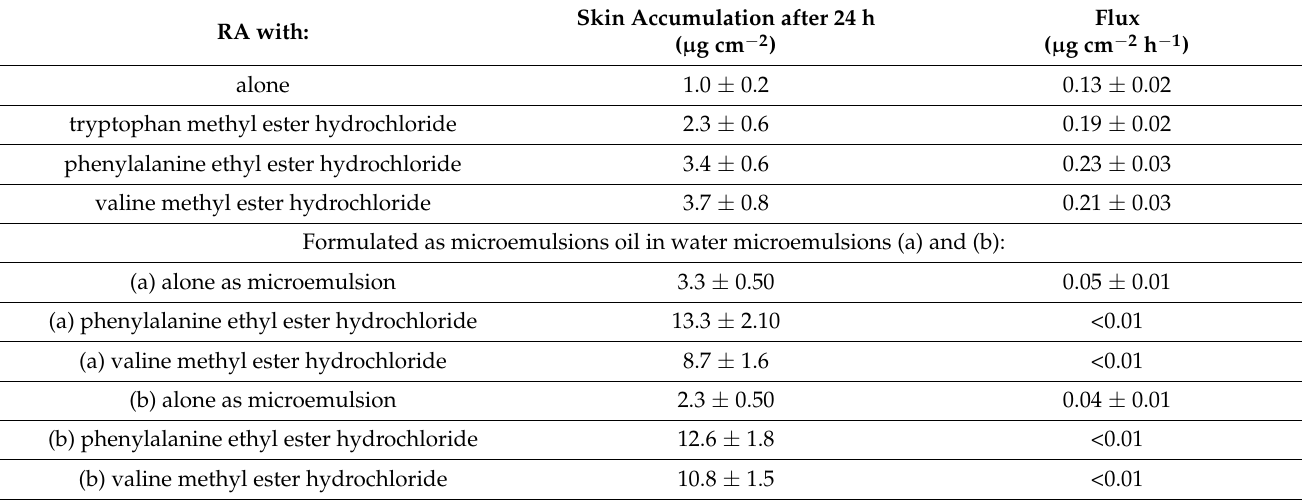
Table 21. Skin accumulation and flux of RA alone and in combination with various counter ions. Formulation used for non-microemulsion studies was a 0.005% ( w/w ) RA in ethanol–pH 6.4 buffer solution (1:2 v/v ), in the absence or presence of counter ions in a 1: 50 molar ratio. Microemulsions contained 0.05% RA in the absence or presence of counter ions in a 1: 50 molar ratio. Microemulsion (a) comprised 56.7% water, 8.8% IPM, 5.3% Epikuron, 13.2% Oramix and 16.0% ethanol; microemulsion (b)) comprised 64.3% water, 10.0% IPM, 11.0% Epikuron, 13.6% Oramix and 9.2% ethanol ( n ≥ 3,